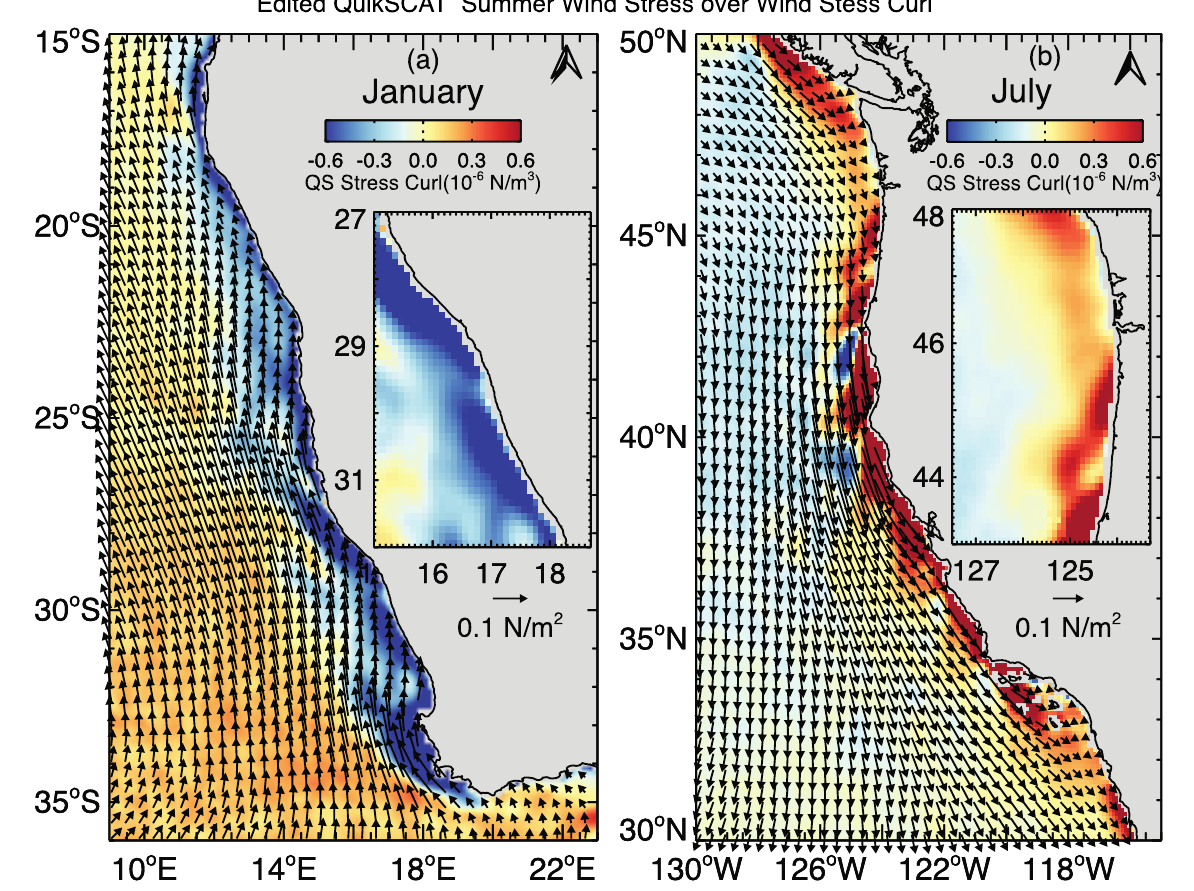
Figure 10. Edited 10-year averages of QuikSCAT wind stress vectors overlaid on wind stress curl for summer along the coasts of ( a ) southern Africa and ( b ) the western U.S, as in Figure 1a,b. L2B wind retrievals marked as suspect by the PCP flag or located within 10 km of land are eliminated.